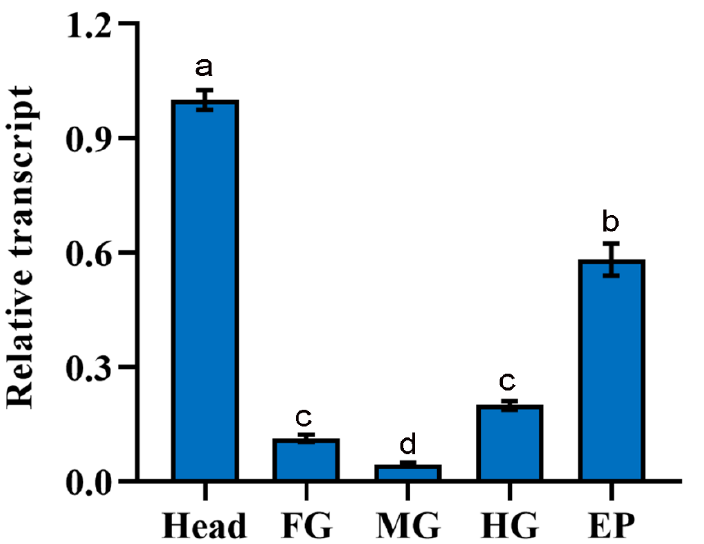
Figure 6. Tissue expression of the chitin synthase A gene ( PoChSA ) in Phthorimaea operculella . The head capsule (Head), foregut (FG), midgut (MG), hindgut (HG) and epidermis (EP) were dissected from the fourth-instar larvae. For each sample, 3 independent pools of 20–30 individuals were measured in technical triplicate using qRT-PCR. The values were calculated using the 2 −ΔΔC T method, using the selected reference genes EF1α and RPL13 . The relative transcripts are the ratios of copy numbers in different developing stages relative to the head capsule, which is set as 1. The columns represent averages, with vertical lines indicating SE. Different letters indicate significant difference at p value < 0.05 using analysis of variance with the Tukey–Kramer test.